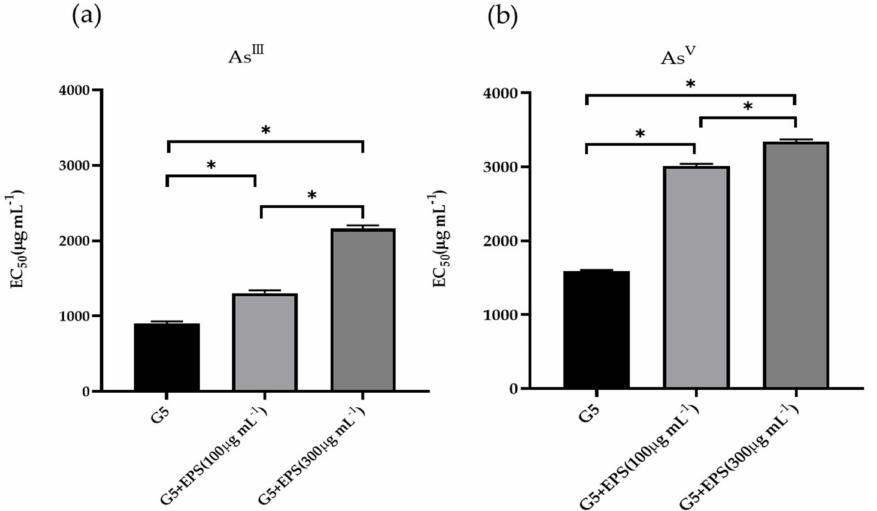
Figure 5. As III ( a ) or As V ( b ) toxicity expressed as EC 50 on V. harveyi G5 (G5) after 15 min of incubation in the presence of EPS B3-15 (100 or 300 µ g mL − 1 ). * Significantly different by ANOVA ( p ≤